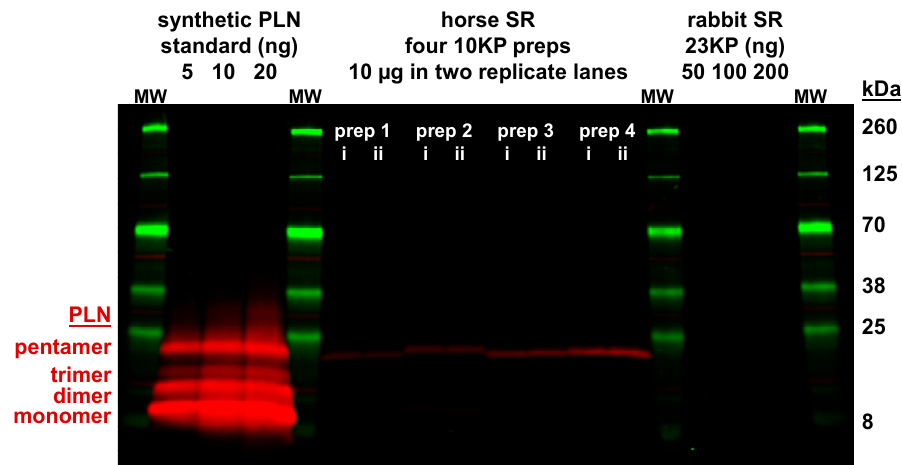
Figure 4. Immunoblot analysis using anti-universal-PLN mAb 2D12 detects minimal expression of PLN protein in horse and rabbit SR vesicles. The primary antibody was the commercial anti-PLN mAb 2D12 with epitope 7 LTRSAAIR 13 , a sequence which is identical in the three PLN orthologs: horse, horse, and rabbit. Samples were electrophoresed through a 4–20% Laemmli gel. Horse SR vesicles (N = 4 preps; 10 µ g protein per lane; each prep run in duplicate lanes) and rabbit SR vesicles (50, 100, 200 ng) were assayed. Synthetic human PLN (5, 10, 20 ng) was used as a quantitative standard. Immunoblotting was performed using mAb 2D12 (primary) and goat anti-mouse-IgG pAb labeled with a 680-nm fluorophore (secondary). Immunolabeling was quantified using the LI-COR laser scanner system. Protein gel markers (kDa) are indicated on the right. The proposed molecular species of PLN (monomer, dimer, trimer, and pentamer) on SDS-PAGE are indicated on the left.